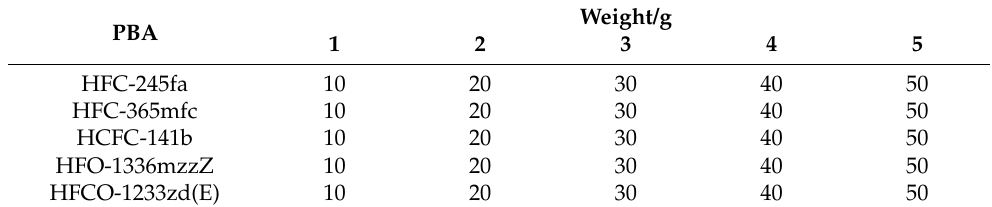
Table 3. PBA loading in the foaming recipes for Group